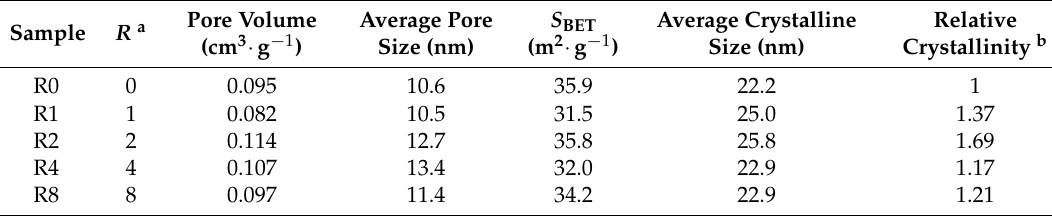
Table 1. Nitrogen adsorption and XRD characterization results of the